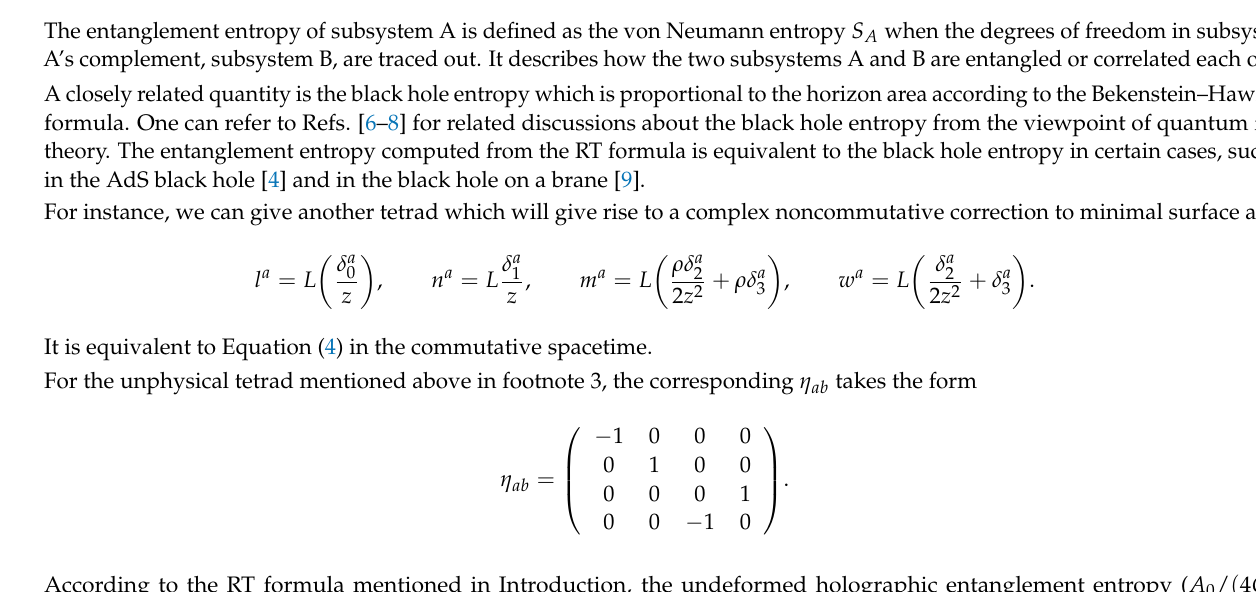
According to the RT formula mentioned in Introduction, the undeformed holographic entanglement entropy ( A 0 / ( 4 G N ) ) corresponds to the entanglement entropy of the boundary field between disk A and its complementary region B because the spacetime maintains the rotating